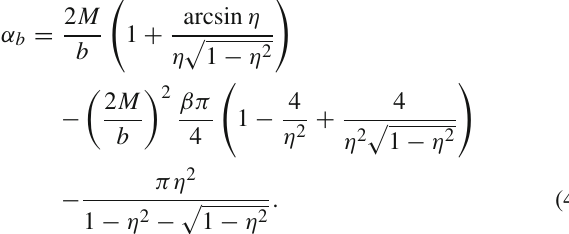
KR gravity and uniform plasma. In Figs. 12, 13 and 14 we performed the analysis for the different values of parameters of KR spacetime. Moreover, we have considered the effect of uniform plasma for the various values of parameters λ and γ . It can be seen from Figs. 12, 13 and 14 that the effect of plasma on the deflection angle increases. The formation of these graphs can be explained by an increase in the